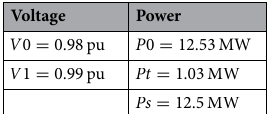
Table 15. Voltage and power values in the selected points of the graphs.